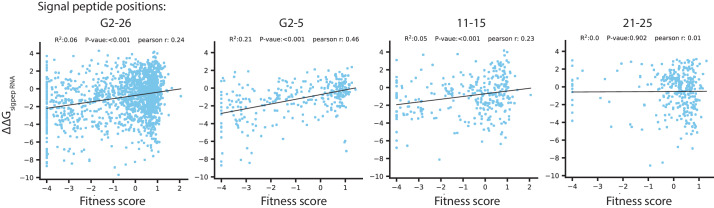
Correlation between the fitness score under selection in 128 µg/mL AMP and predicted ΔΔG of RNA folding for codon variants in the signal peptide.The energy ΔΔG are calculated as the difference in ΔG between wtVIM-2 mRNA transcript and the transcript of each signal peptide codon-variant (isolating the contributions from the 5’ UTR and the signal peptide region). The ΔΔG is normalized to a multiple of the thermal energy factor kT, such that a ΔΔG of 1 indicates a 1 × kT increase in ΔG of the variant over the wt. The label above each plot indicates the positions where codon variants were considered for the correlation (G2 refers to the Glycine two in the inhouse sequence that is not a part of wtVIM-2).